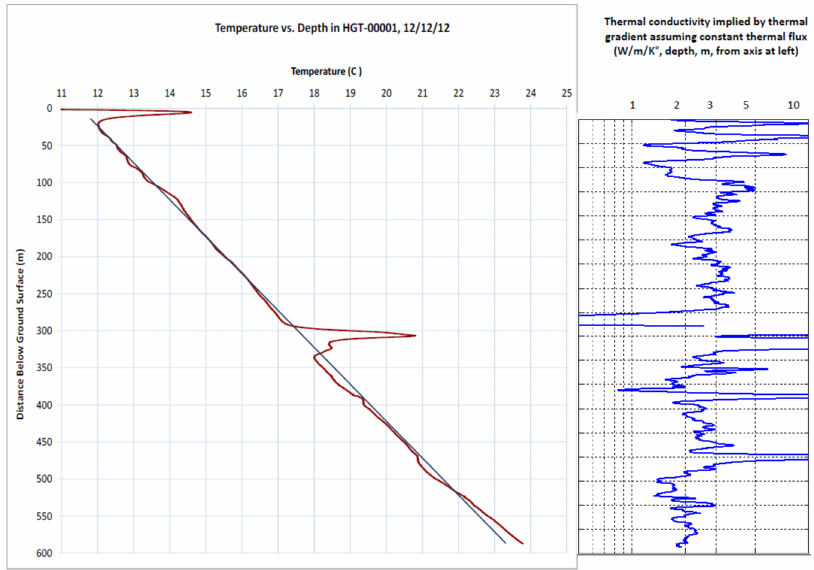
Figure 5. Left : Average temperature in borehole with no heating (19:47, 12 December 2012 to 00:02, 13 December 2013). The red line is the measured average temperature and the blue line is a straight line for visual comparison. Right : Implied thermal conductivity of formation assuming uniform constant vertical heat flux. Note higher variability above the water table at 122 m and reduced conductivity below about 475 m, where formation is believed to